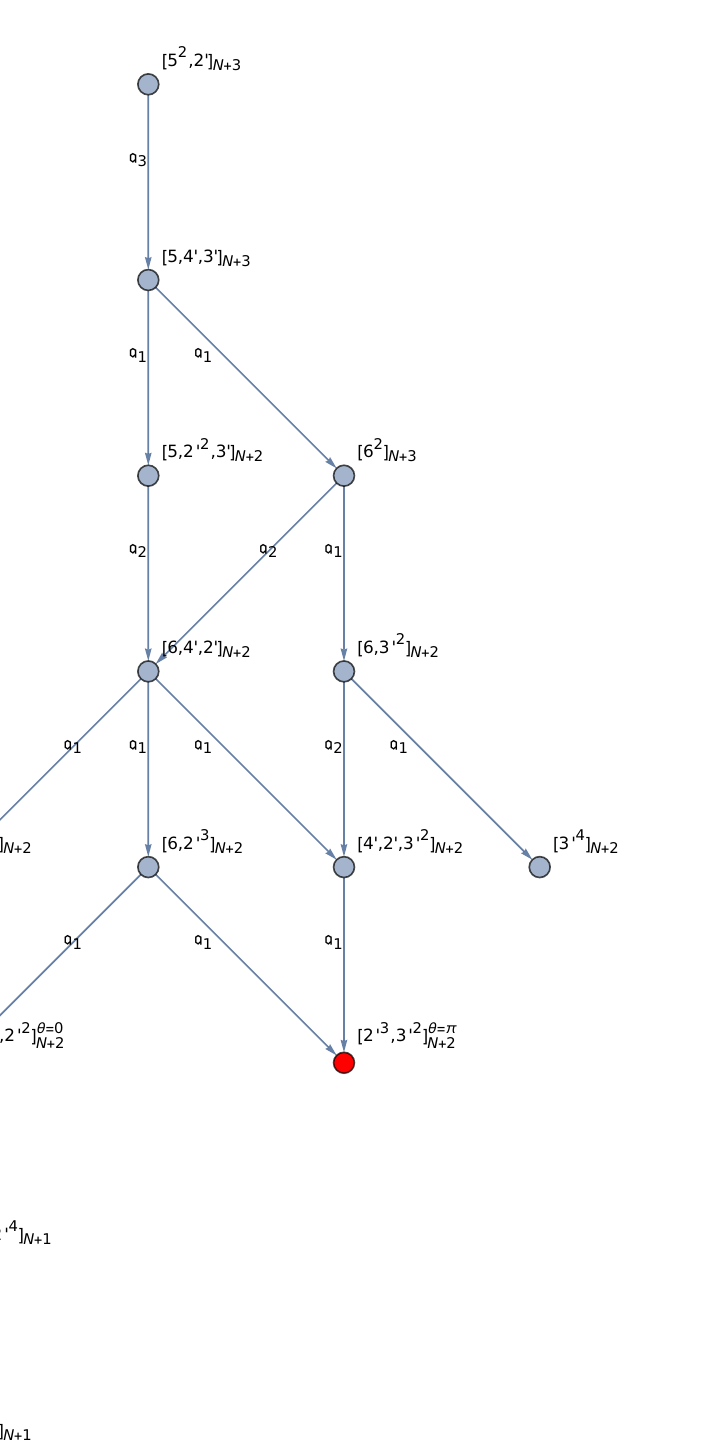
Figure 9. Hierarchy for massive E 4 -theories with n 0 = 5 and k = 17